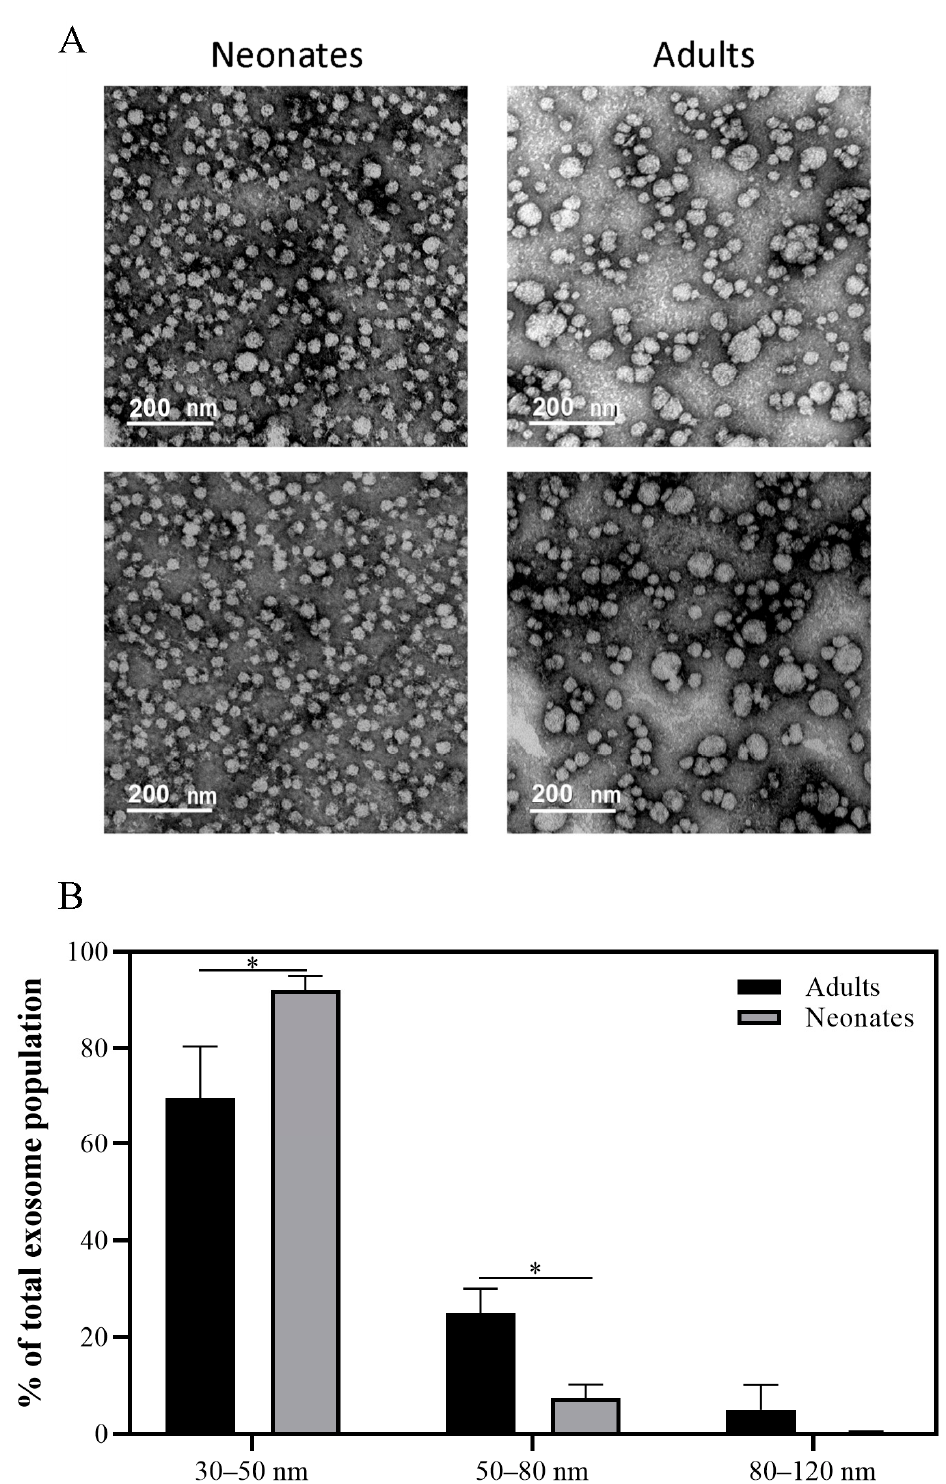
Figure 2. Characterization of exosomes. ( A ) Representative images of plasmatic adult and neonate exosomes from the transmission electron microscopy (TEM) ( n = 3/group). The scale bars of images are 200 nm. The acquisition was at 100 kV. The magnification was 100,000 × . The images were processed using MIP4 software. ( B ) Percentage of exosomes in different diameter size ranges (30–50 nm; 50–80 nm; 80–120 nm) in adult and neonate samples. Values represent average population percentage relative to total exosome population ± SD ( n = 3/group); (* p < 0.05).